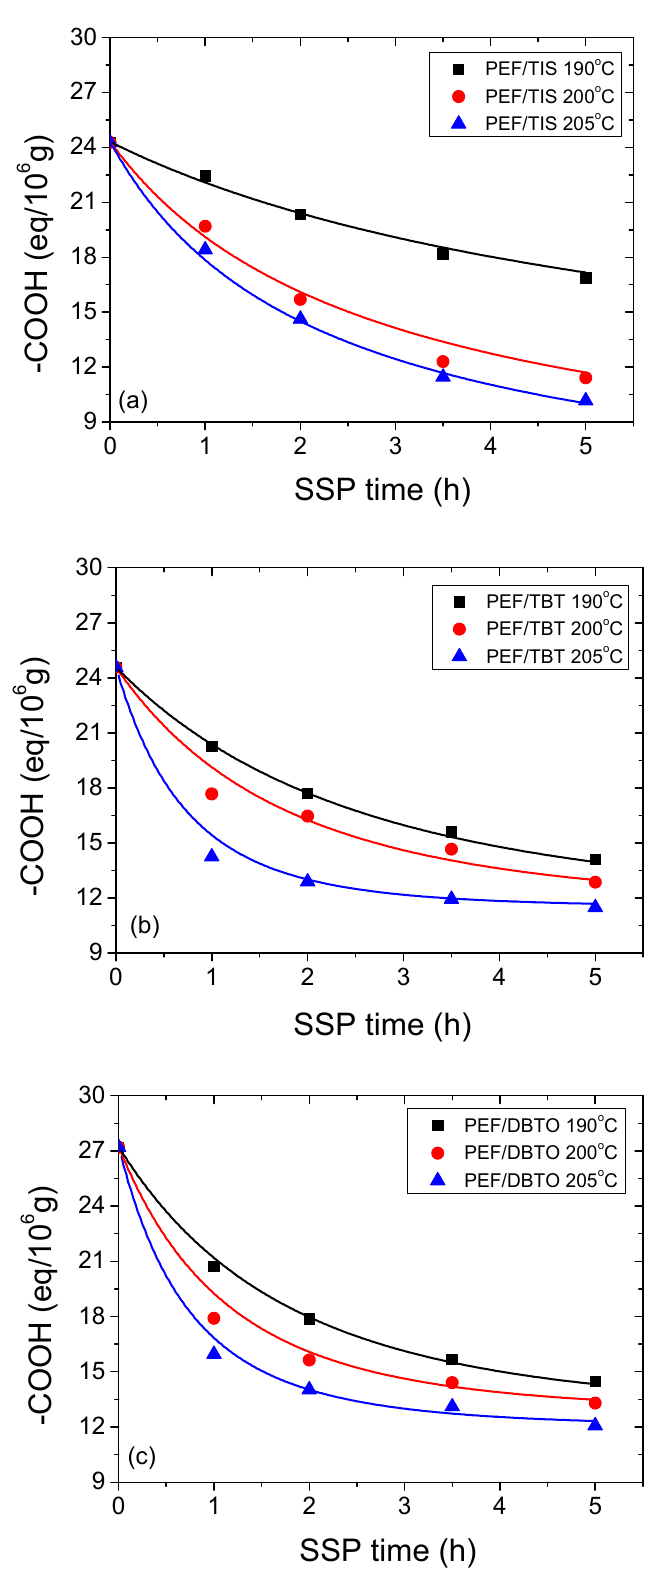
Figure 3. Variation of carboxyl end groups with time during PEF/TIS ( a ), PEF/TBT ( b ), and PEF/DBTO ( c ) SSP at different temperatures. Continuous lines represent the theoretical kinetic model simulation results.